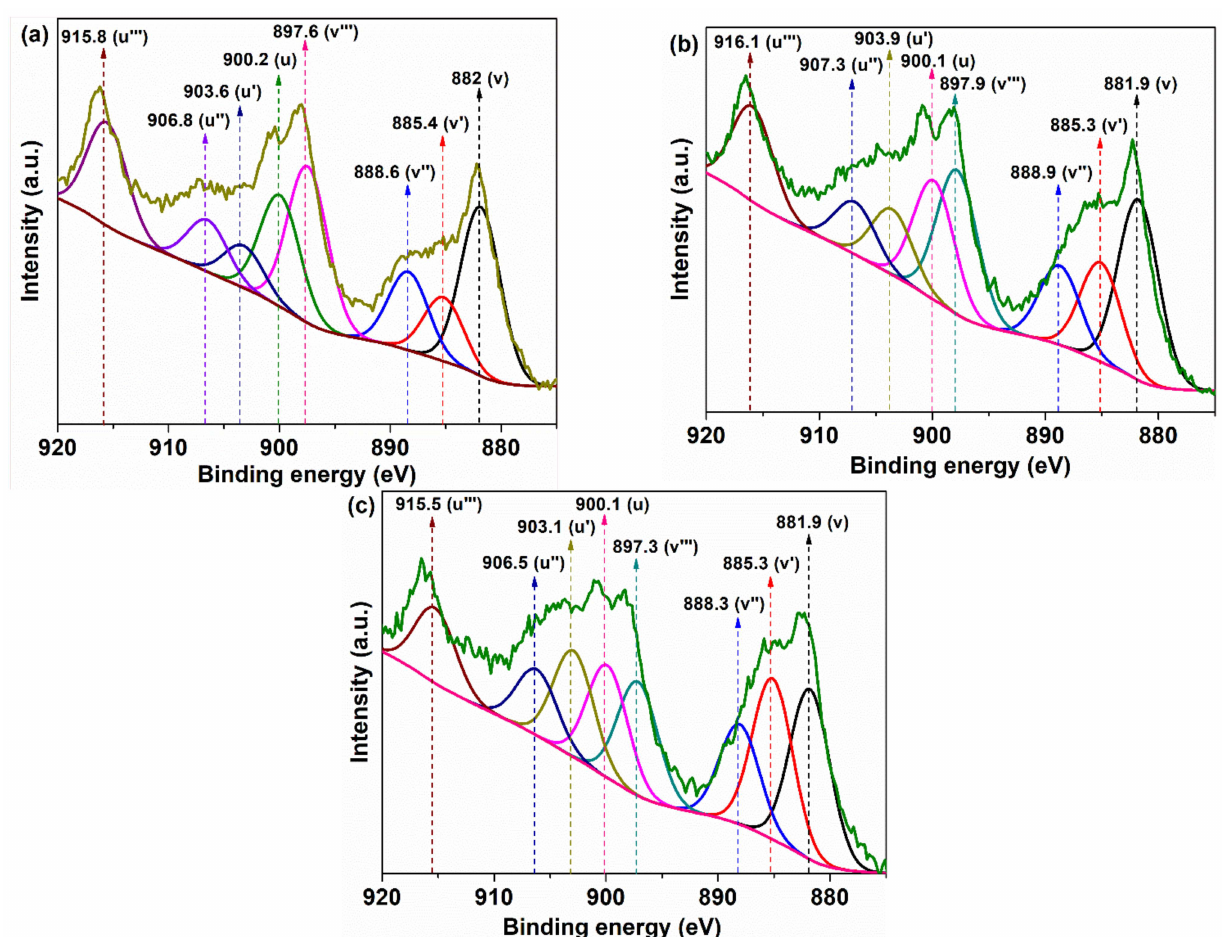
Figure 3. Ce 3d core-level XPS pattern of cerium oxide nanoparticles: ( a ) CeO-1, ( b ) CeO-2, and ( c )